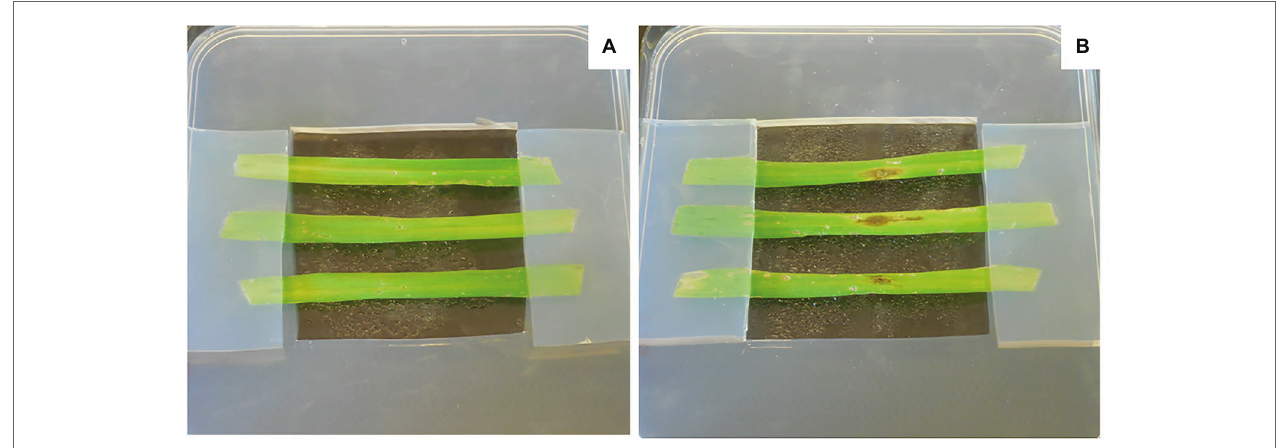
FIGURE 6 | Assessment on detached leaves. The barley leaves were disinfected in an ethanol bath at 70 ° C followed by rinsing in three successive sterile water baths. All the leaves were cut to the same length then placed on agar-agar medium. These leaves were then wounded with a wooden pick. A volume of 10 μ l was deposited at the level of the wound containing sterile water for a control condition (A) or P. teres spores at a concentration of 10 5 spores.ml −1 for the infected condition (B)